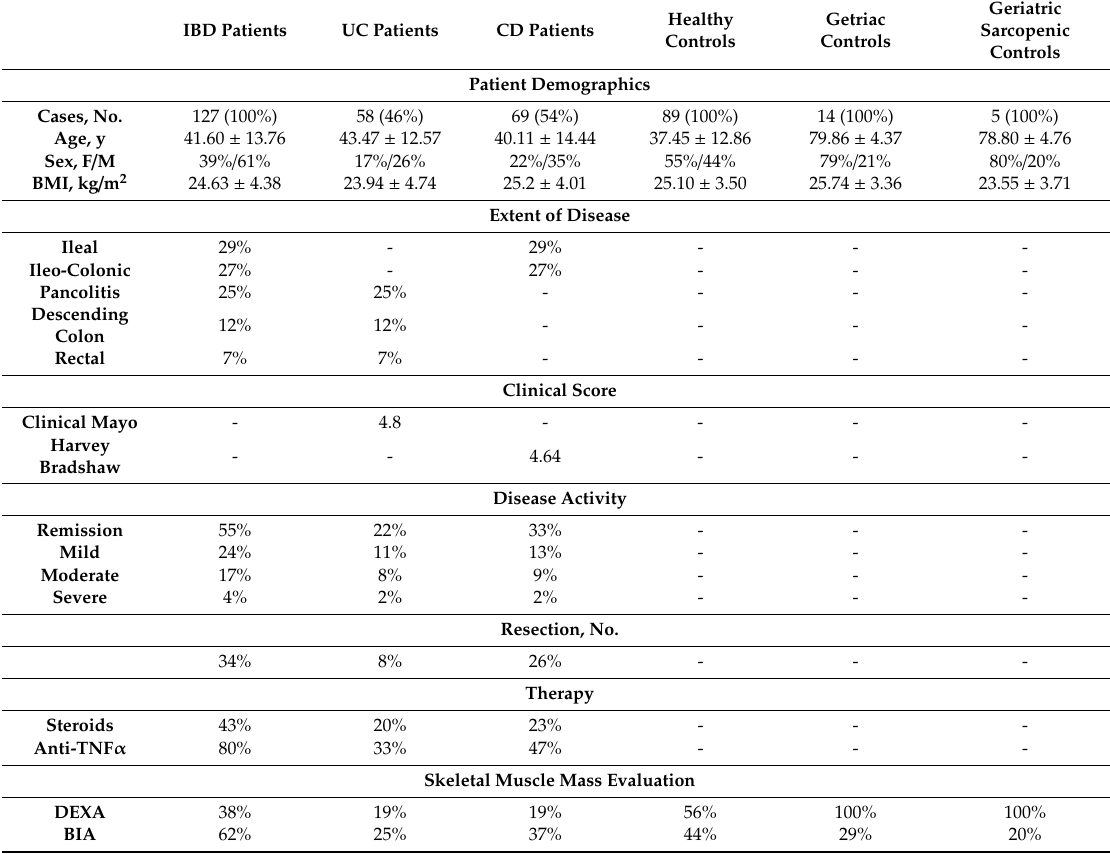
Table 1. Patients